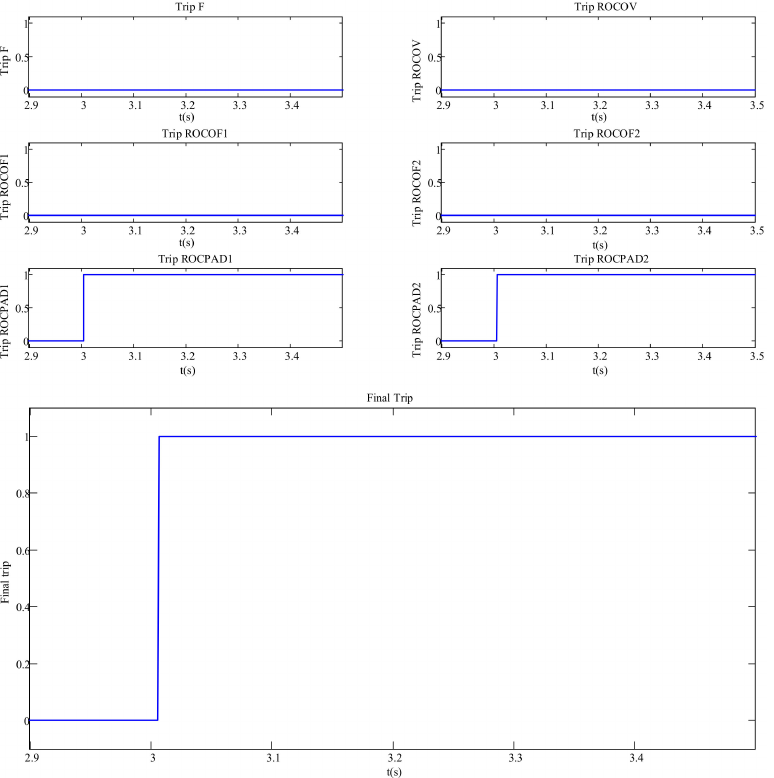
Figure 16. Trip signal of relays and the proposed algorithm in islanding mode with 0% power